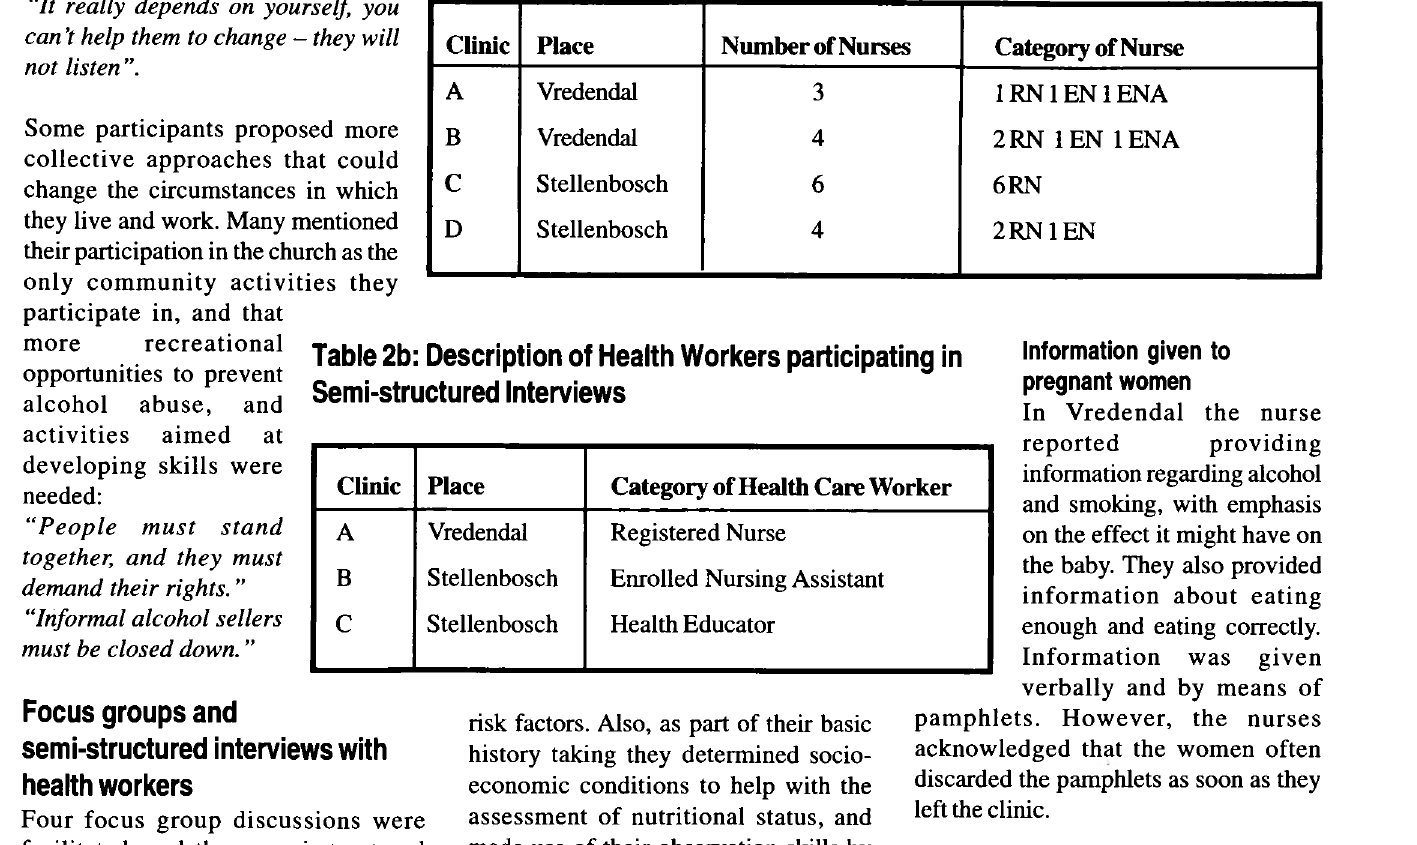
Table 2a: Description of Nurses Focus Groups